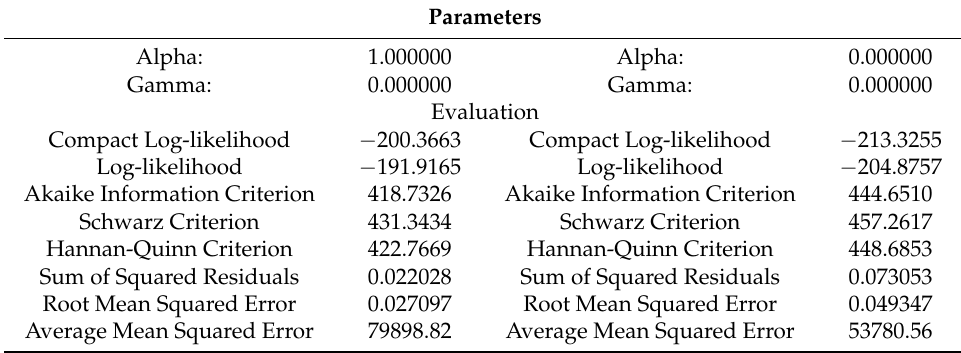
Table 9. Holt-Winter’s model and evaluation parameters for May and December